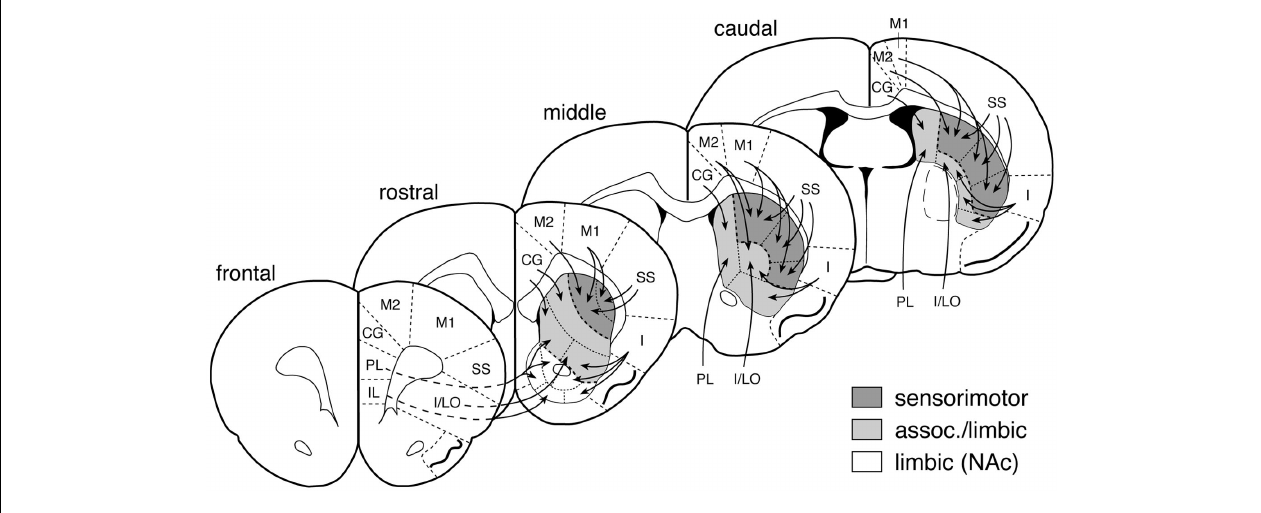
limbic/nucleus accumbens (NAc) circuits are indicated by shading. Abbreviations (medial–lateral): IL, infralimbic; PL, prelimbic; CG, cingulate; M2, medial agranular; M1, motor; SS, somatosensory; I/LO, insular/lateral orbital; I,